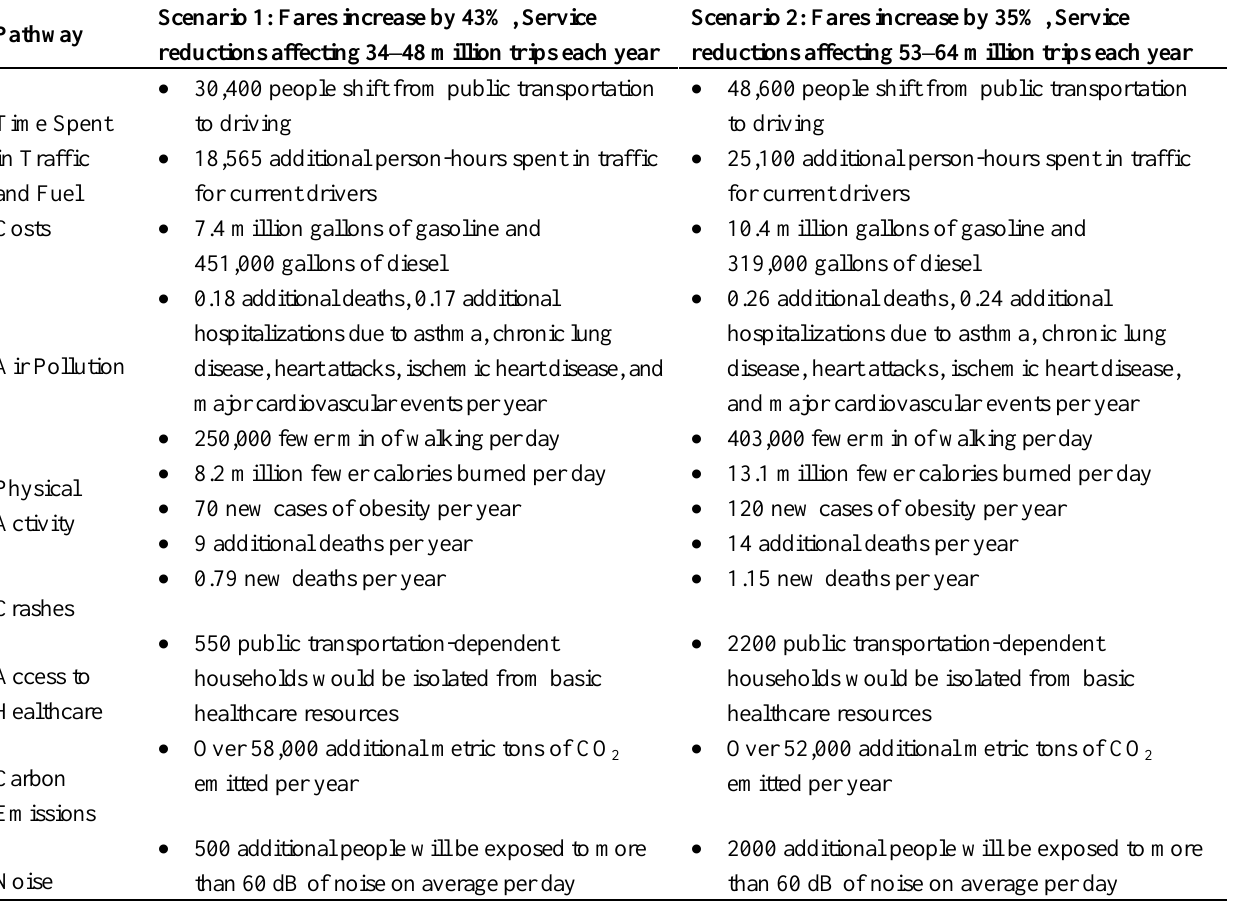
Table 1. Annual impacts of proposed public transportation fare increases and service cuts.